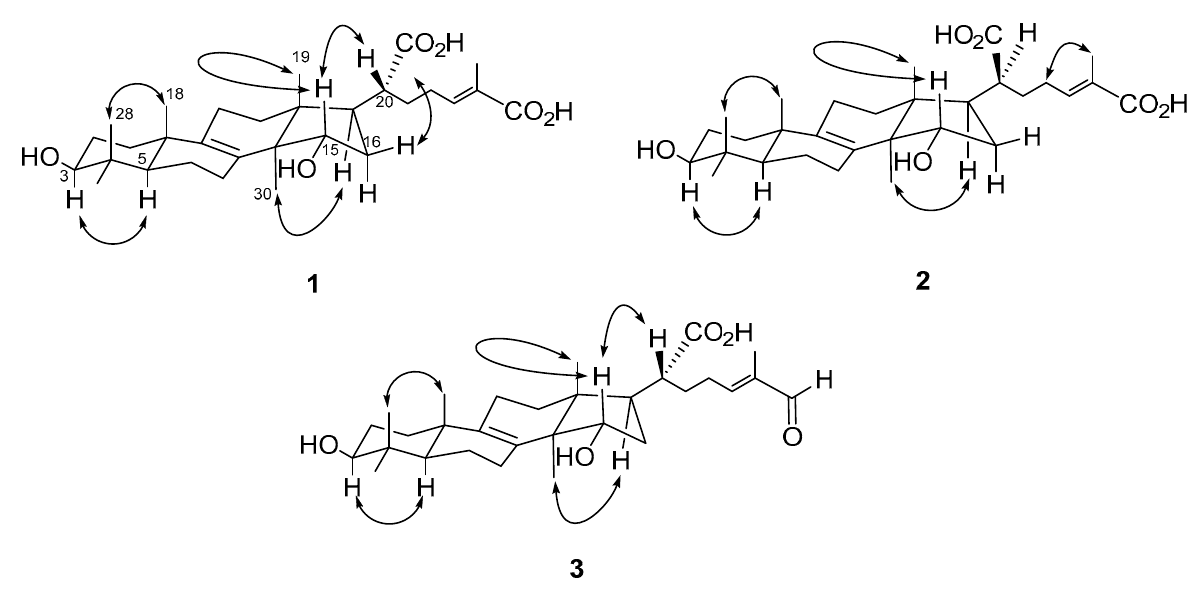
Figure 3. Key NOESY correlations ( ↔ ) of compounds 1 – 3 . Table 2. 1 H and 13 C NMR spectroscopic data of compounds 1 – 3 .